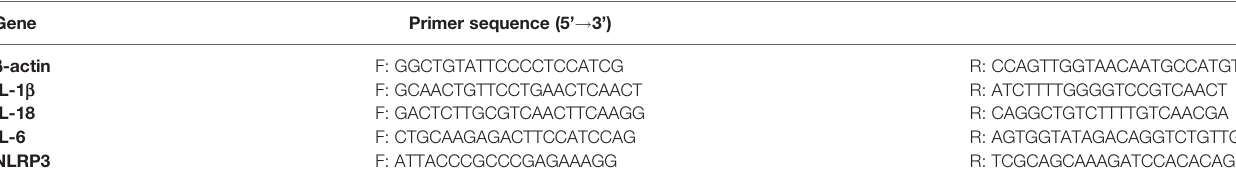
TABLE 1 | The primers used in the